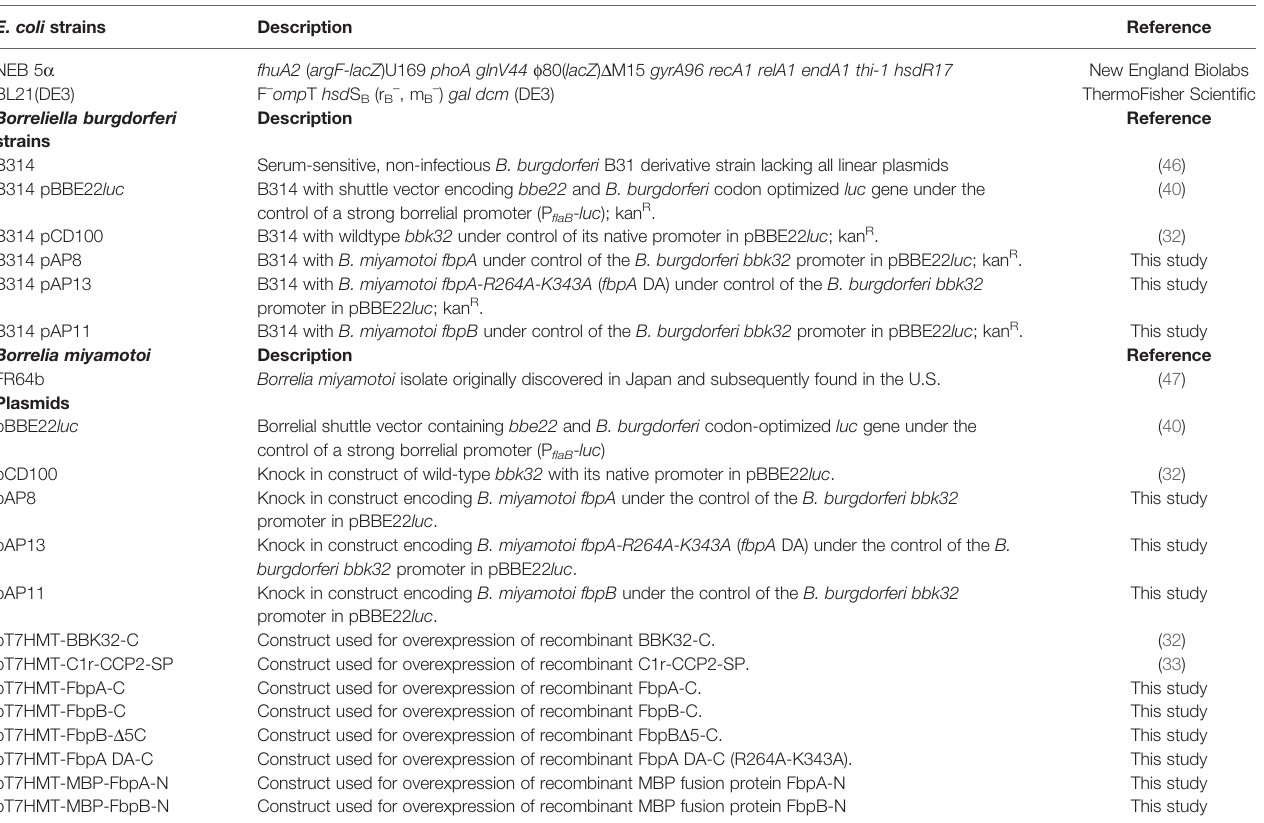
TABLE 1 | Bacterial Strains and Plasmid Constructs used in this